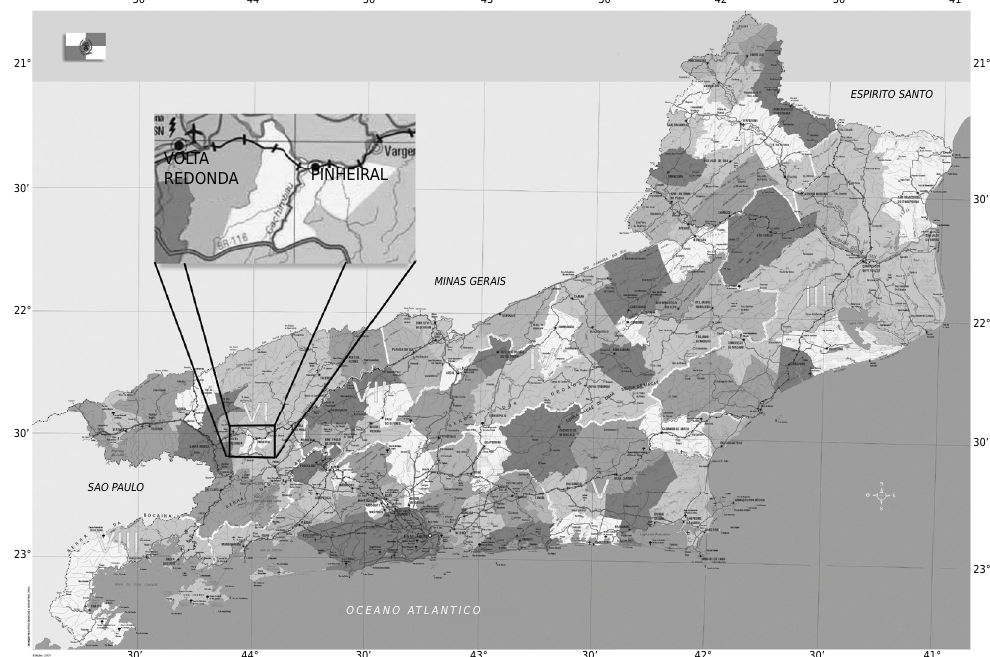
Figure 1. Study area in Pinheiral, Rio de Janeiro state. Source: CIDE – Center of Information and Data of Rio de